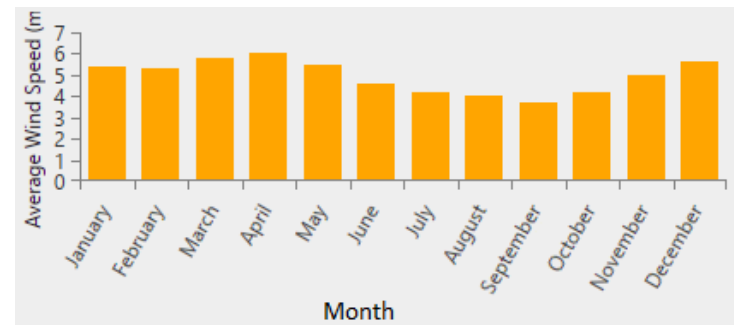
Figure 8. The average monthly wind speed measured at 50 m in Djoundé .